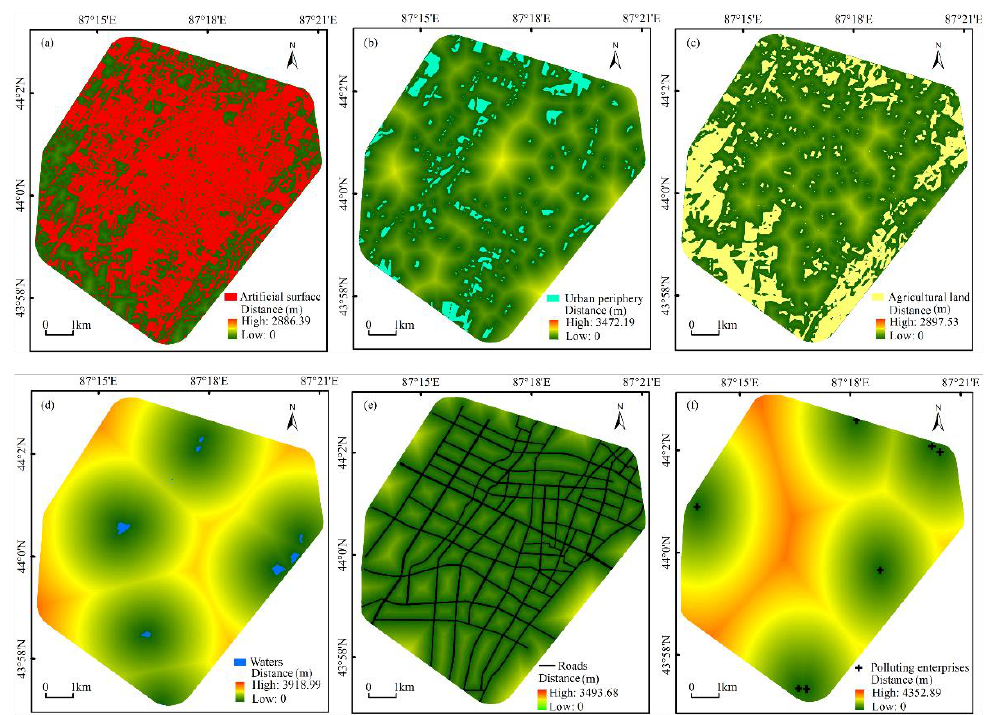
Figure 2. Spatial distance between sampling points and influence factors. ( a – f ) represent the Euclidean distances between sampling sites and artificial surfaces, urban periphery, agricultural land, waterbodies, roads, and polluting enterprises, respectively.